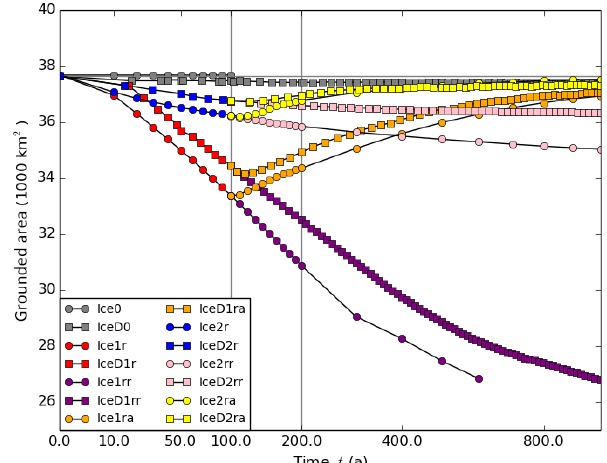
Figure 7. Grounded area against time for all of the simulations. Lines with circles show the results based on BISICLES without the damage model and those with squares show the results based on BISICLES with the damage model. Grey curves show the results of the control run Ice0, IceD0; red curves show the results of Ice1r, IceD1r; orange curves show the results of Ice1ra, IceD1ra; purple curves show the results of Ice1rr, IceD1rr; blue curves show the results of Ice2r, IceD2r; yellow curves show the results of Ice2ra, IceD2ra; pink curves show the results of Ice2rr, IceD2rr. BISI- CLES_D produces slightly less retreat than